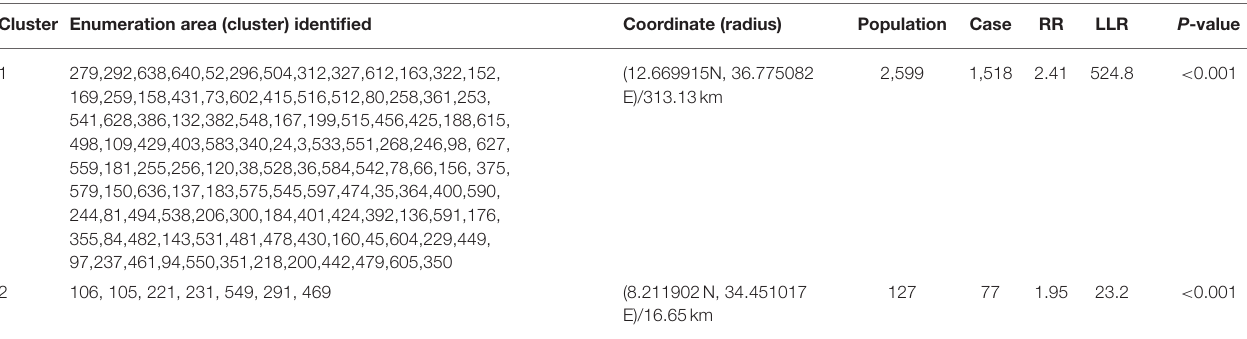
TABLE 3 | Significant spatial clusters with high-rate risky health behavior among males in Ethiopia, 2016. Cluster Enumeration area (cluster) identified Coordinate (radius) Population Case RR LLR P